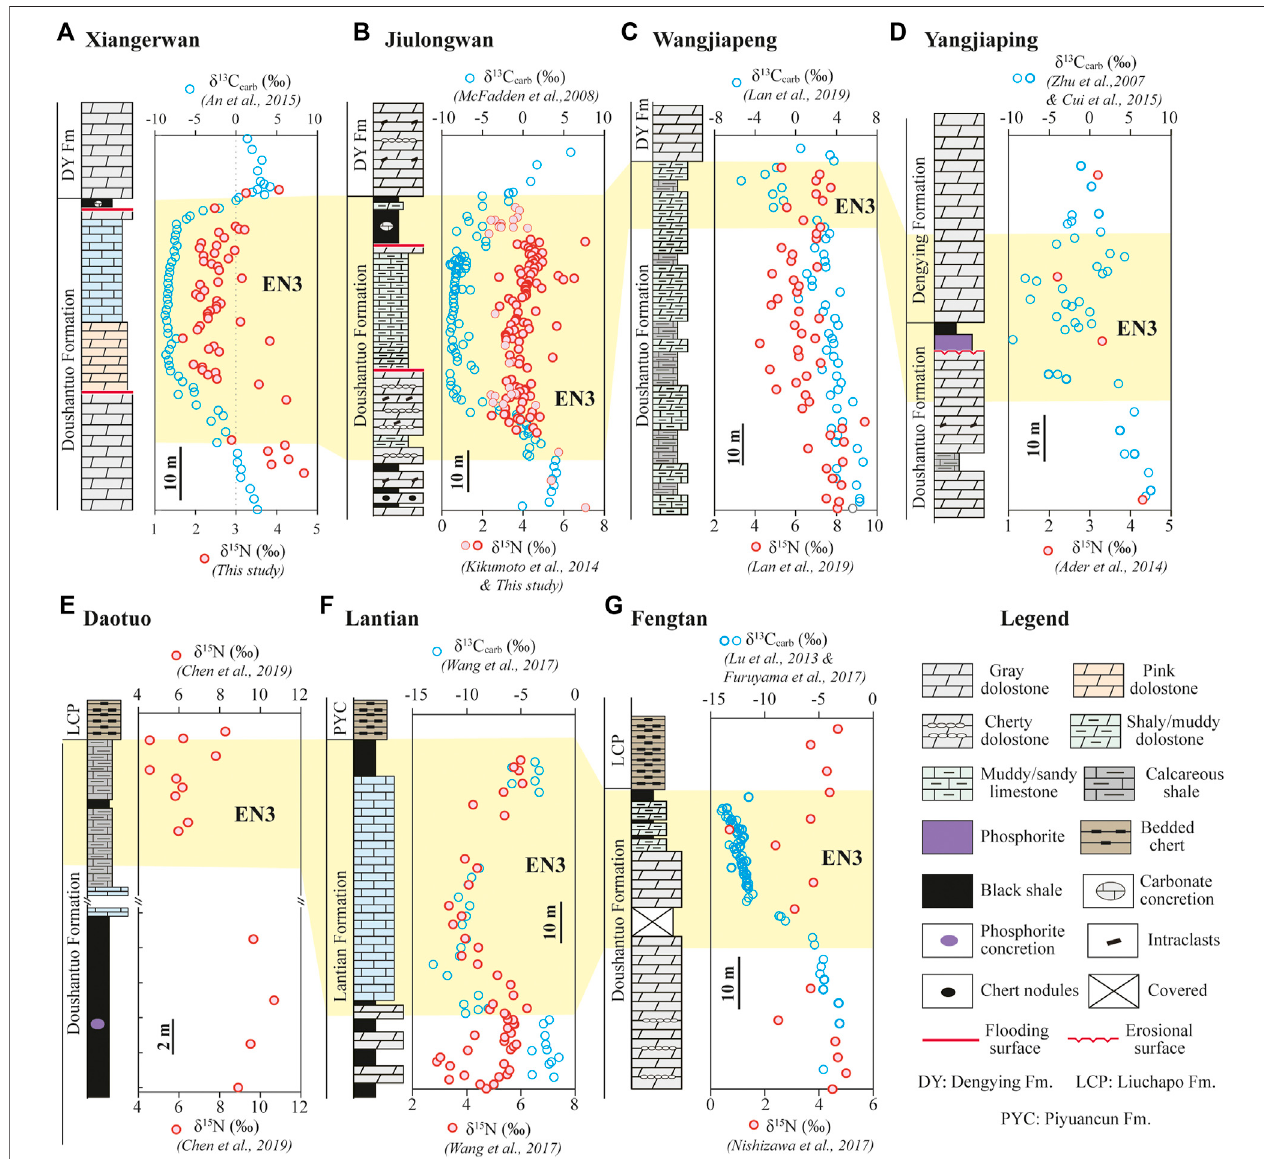
FIGURE 6 | Correlation of δ 15 N variations across the Shuram-EN3 excursion in different sections.